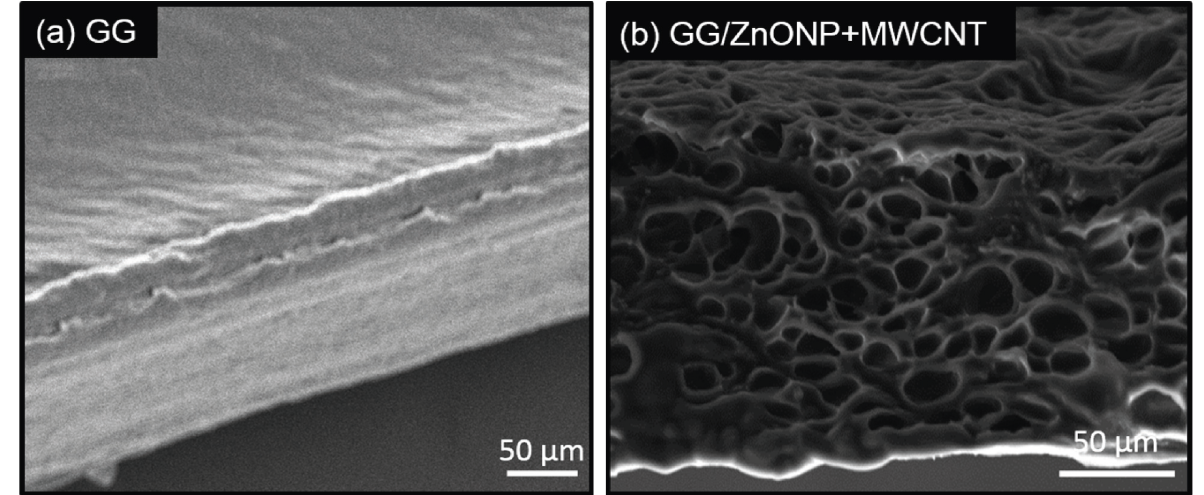
Figure 5: Cross-section SEM images of (a) GG film and (b) GG/ZnONP+MWCNT bionanocomposite film. Table 1: Water absorption capacity analysis for GG and